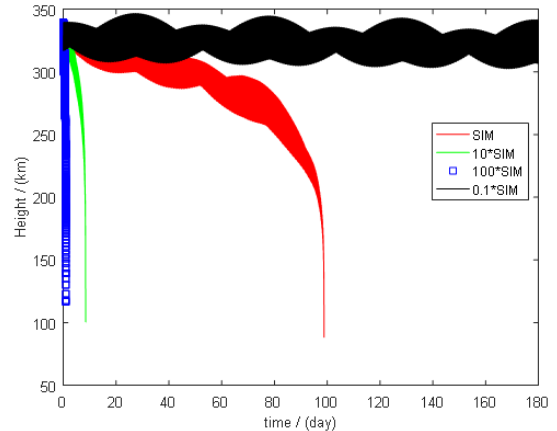
Figure 4. Effects of surface-mass ratio changes on ORB-3 satellite height forecast error